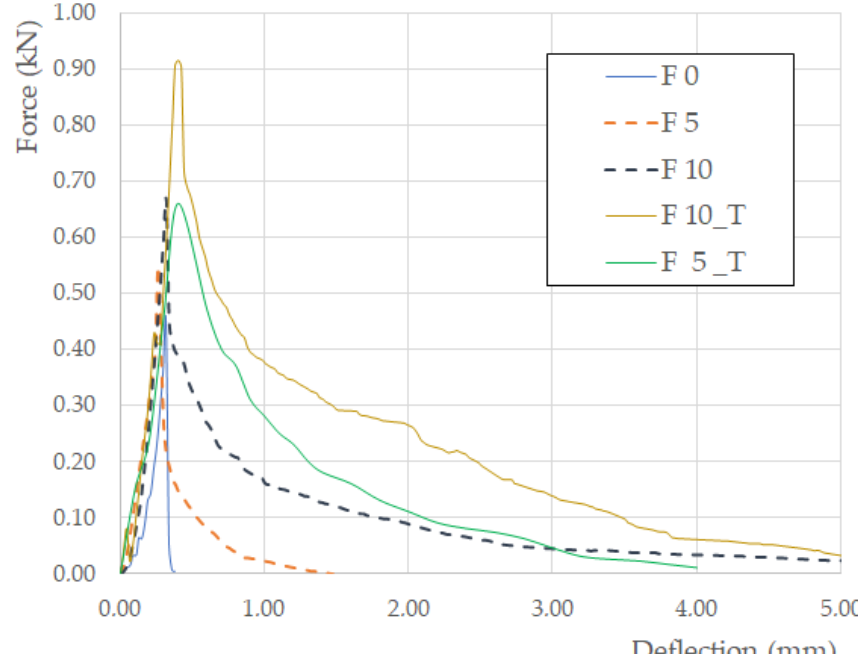
Figure 6. Load deflection plots for F materials.